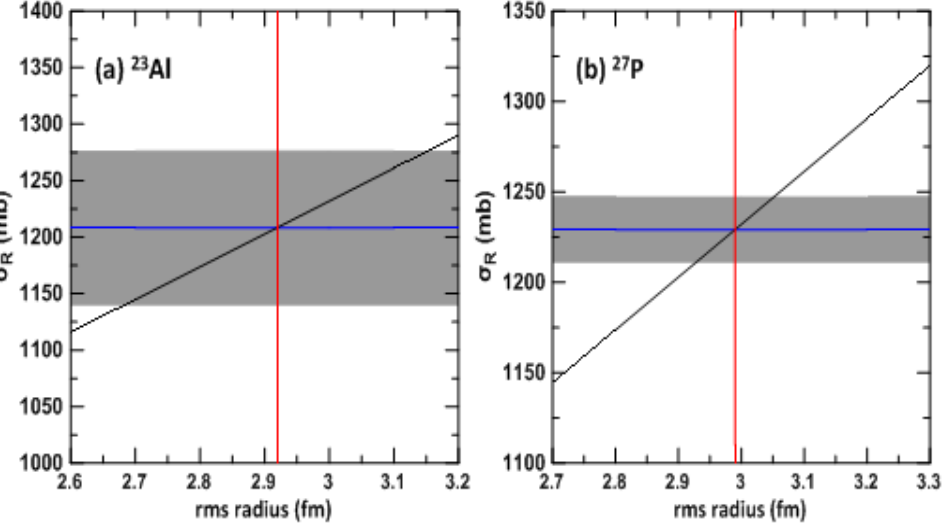
Fig. 7: The reaction cross section versus the matter rms radii for the halo nuclei 23 Al and 27